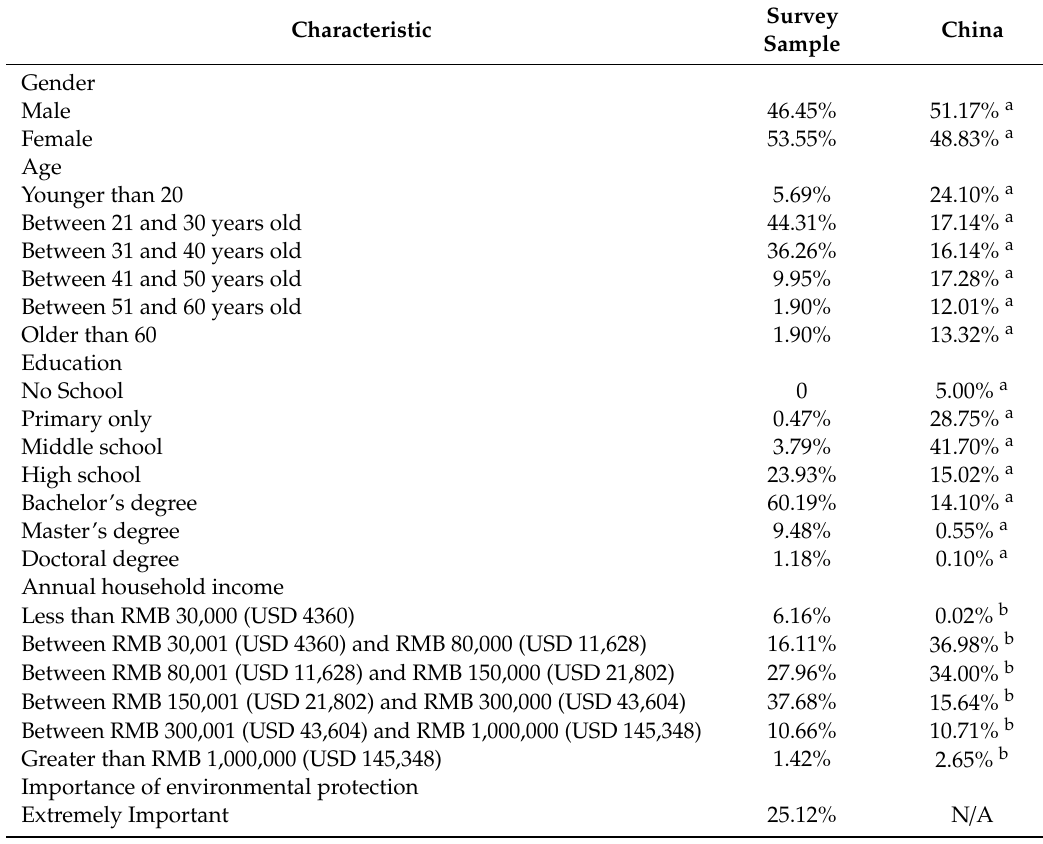
Table 3. Summary of participant demographic information and China’s population from 2017 census